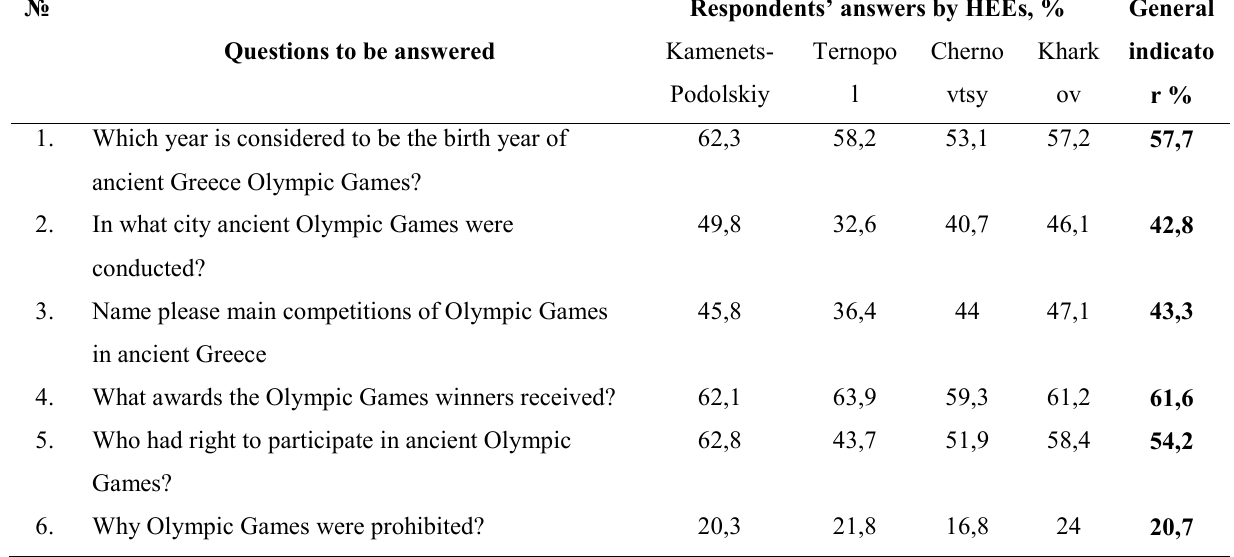
Table 1. Formation of Olympic knowledge system in